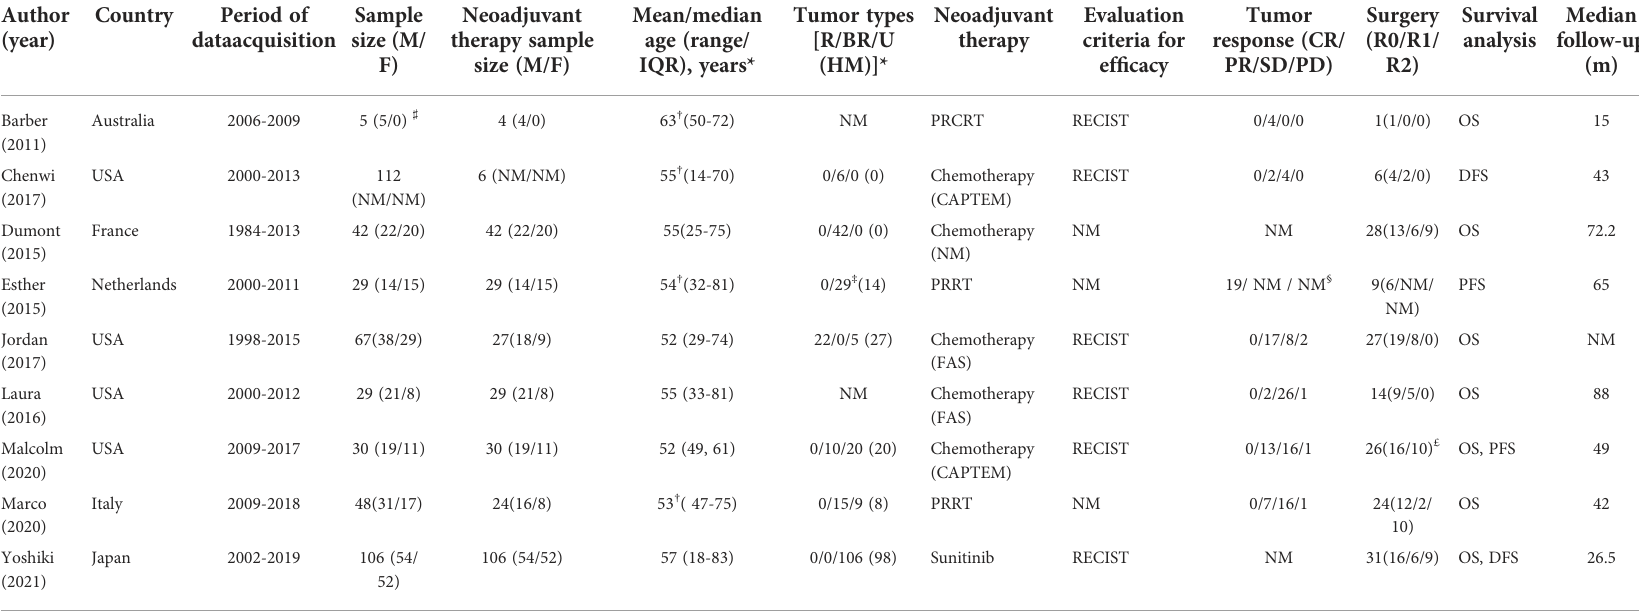
TABLE 1 Basic characteristics of all studies included in the